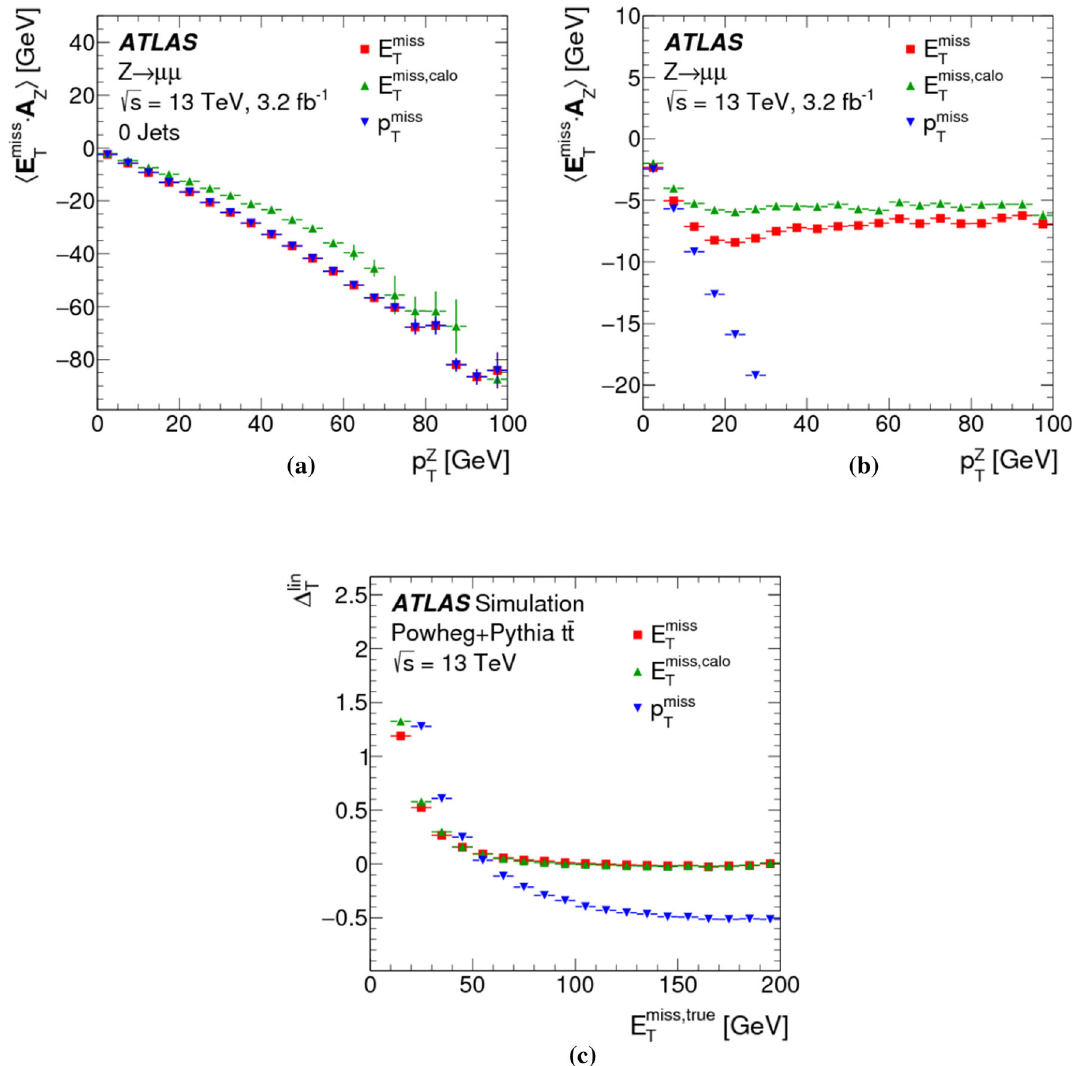
Fig. 16 Comparison of the reference E miss lated according to Eqs. (9) and (10), are shown as a function of p Z , the calorimeter-based T E miss , calo the linearity of the reference E miss and track-only-based p miss response in an a exclusive and T T an b inclusive Z → μμ sample from data. The projections of the lated according to Eq. (11), is shown as a function of the true E miss , true respective E miss , E miss , calo , and p miss onto the direction of p Z , calcu- for the t ¯ t -production MC simulation sample T T T T